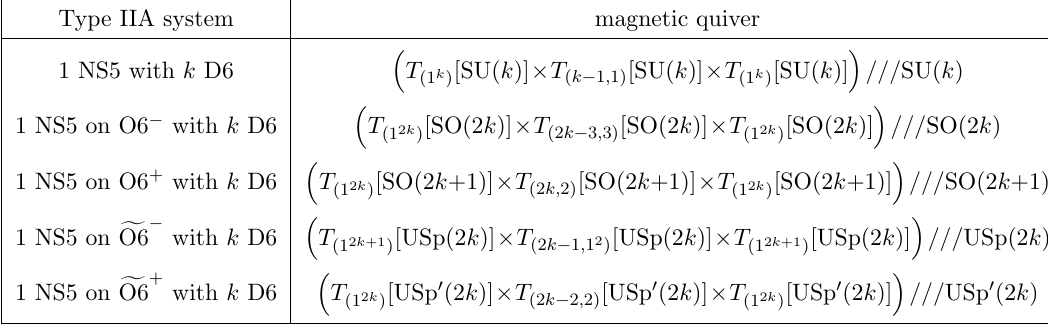
Table 6 . The Higgs branch at the origin of the tensor branch can be described by a magnetic quiver obtained from three T (cid:26) [ G ] theories [48] glued along the common G (cid:13)avour node, which is denoted by ===G